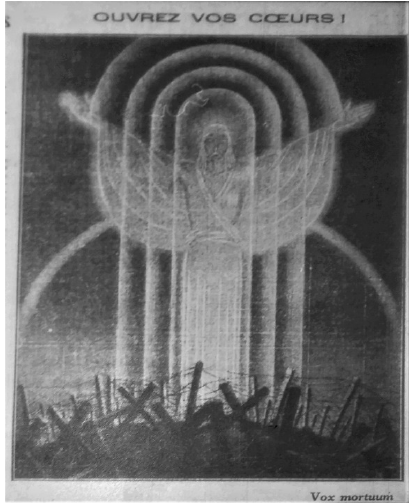
Figure 9. “Open Your Hearts! The Voices of the Dead.” La Patrie Humaine. 26 May 1933. Ink on Paper. Bibliothèque Nationale de France.